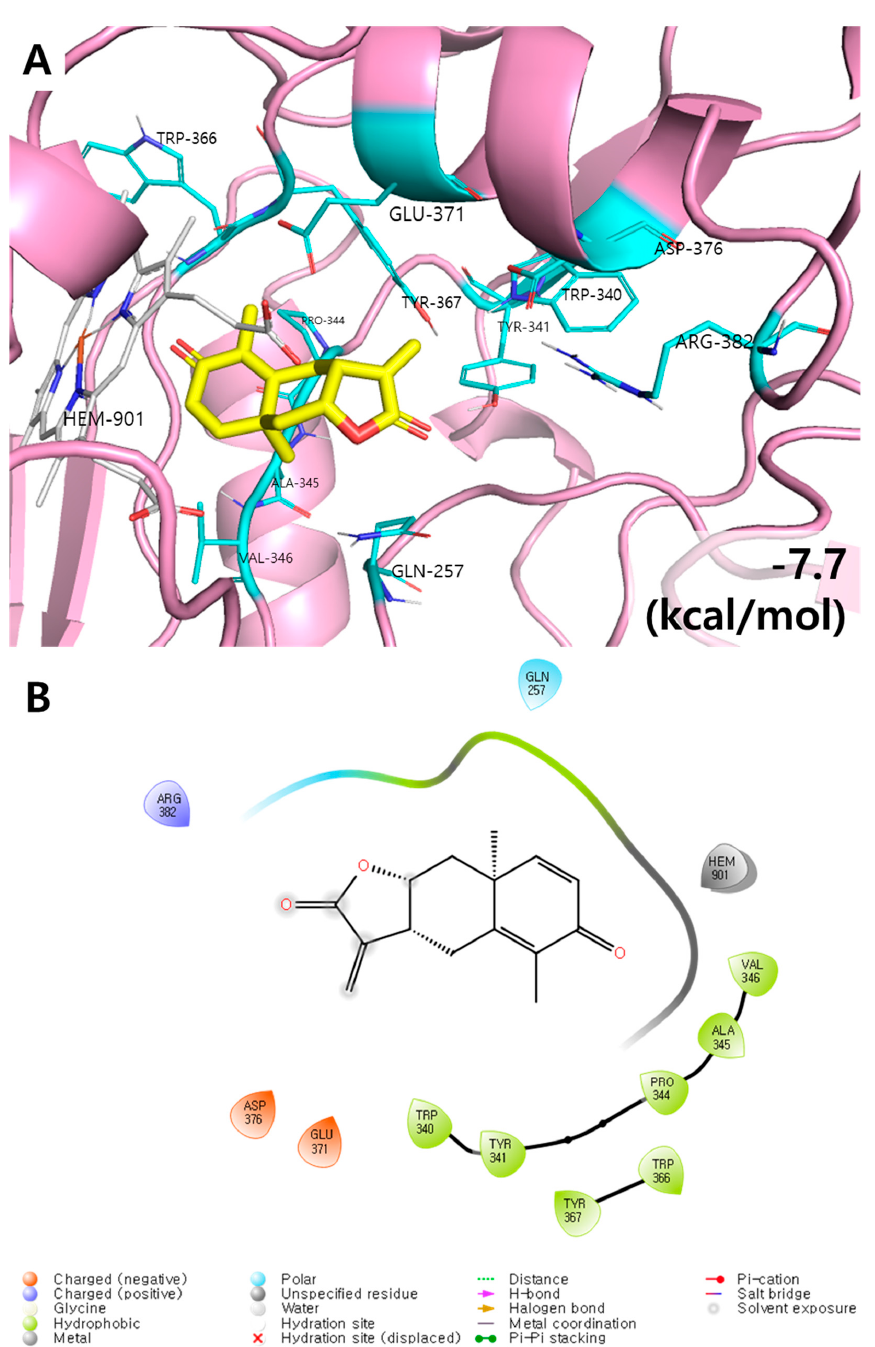
Figure 3. Molecular docking results of yomogin and iNOS enzyme. The 3D ( A ) and 2D ( B ) diagrams of iNOS and yomogin molecular docking simulations were determined at the lowest energy conformation (RMSD < 1.0) Each atom is colored as follows: red for oxygen, blue for nitrogen, and yellow/cyan for carbon. Only the interacting residues are labeled for clarity. PyMOL and Maestro were used to generate graphical representations of the interactions.